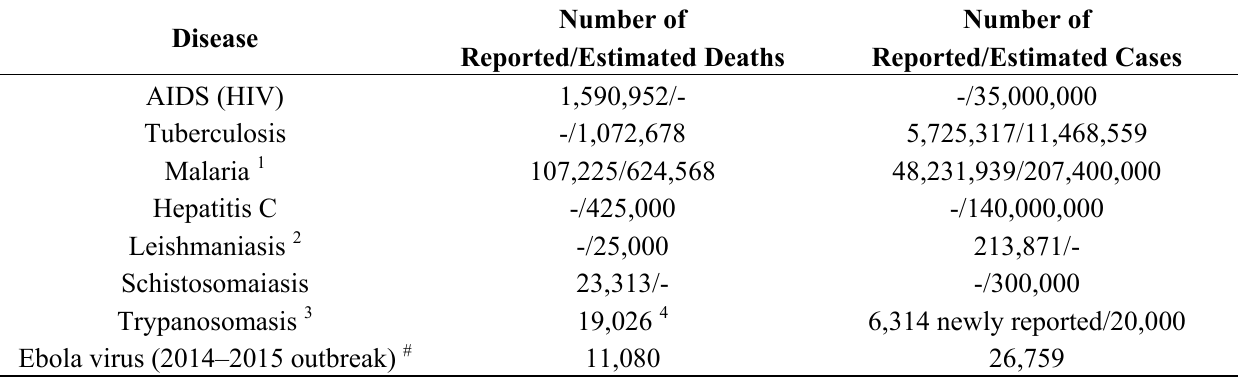
Table 1. Number of deaths caused in 2013 by infectious and parasitic diseases for which effective vaccines are not yet